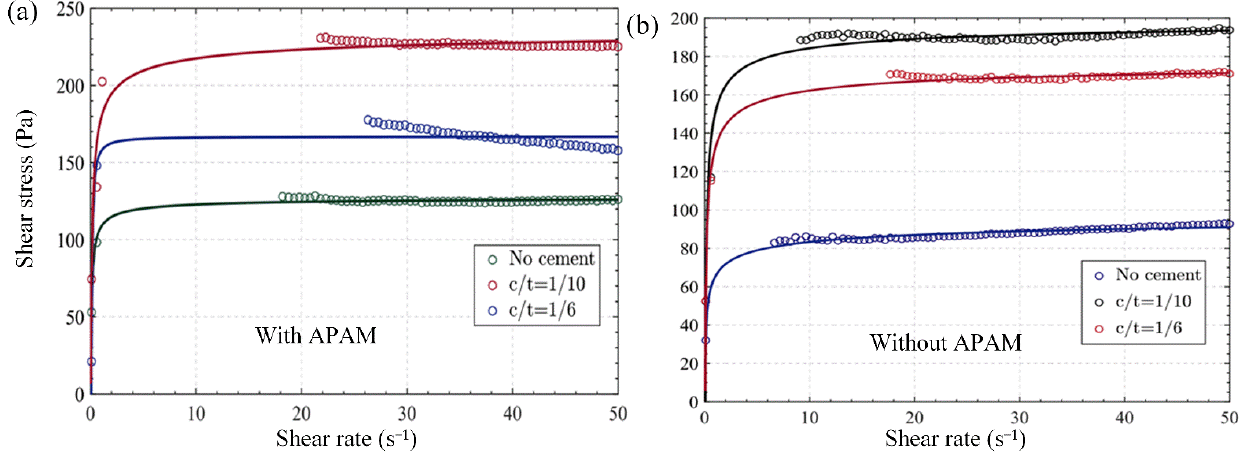
Figure 10. Flow curves of samples with different C/T ratio: ( a ) shear rate vs. shear stress (without APAM); ( b ) shear rate vs. shear stress (with APAM).